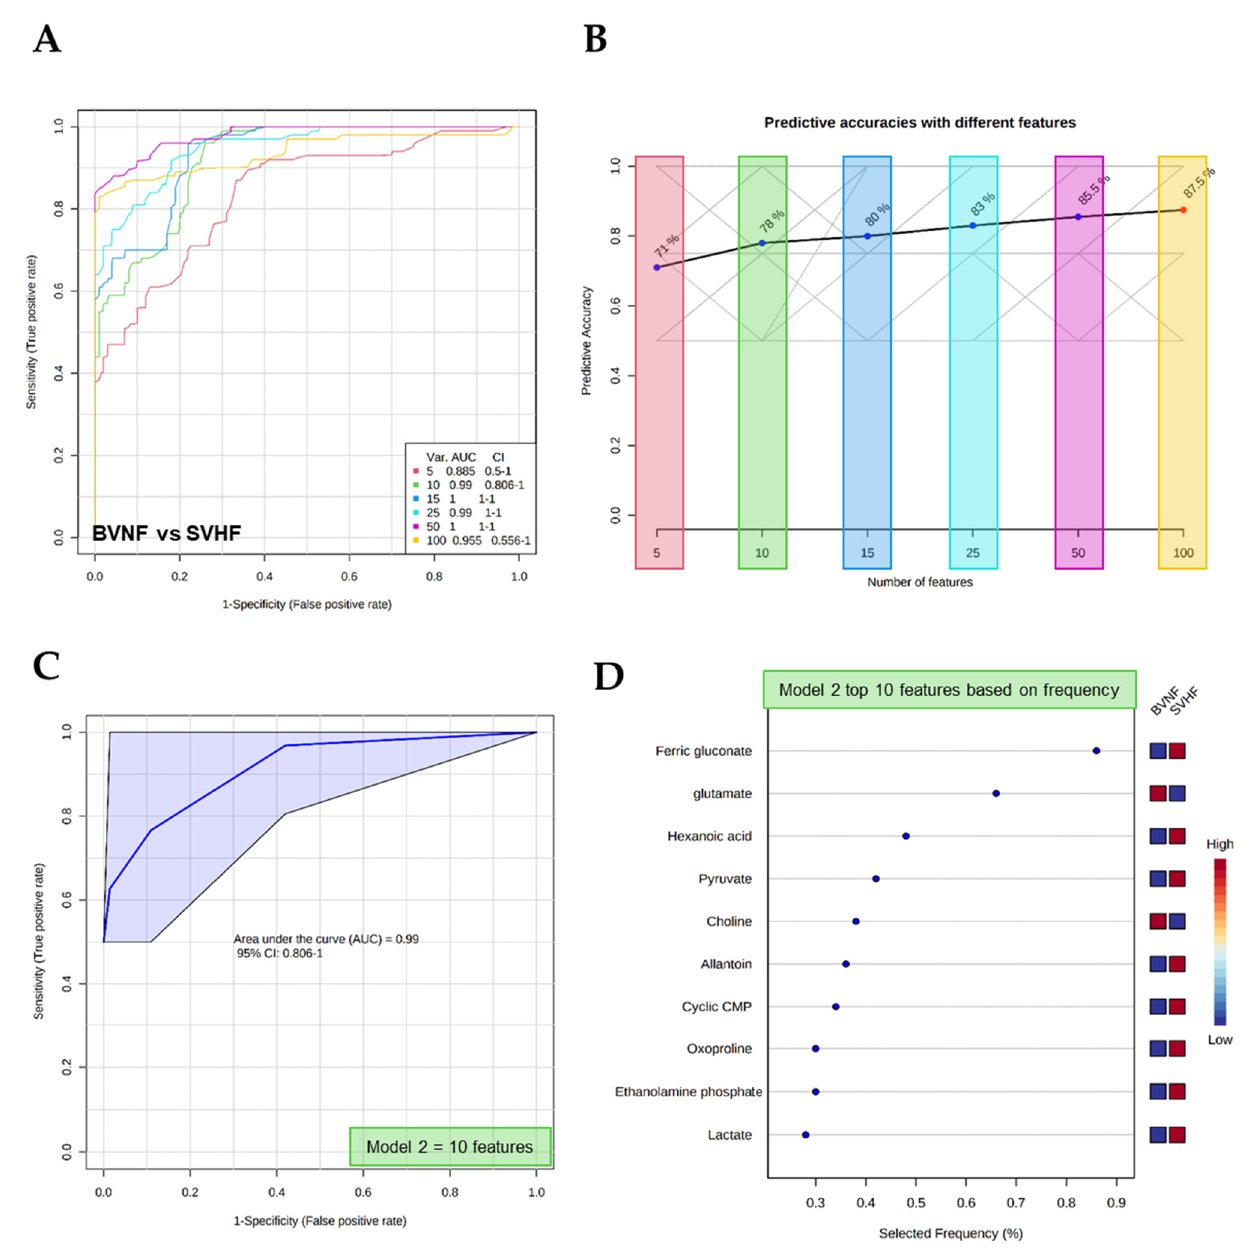
Figure 6. Multivariate analysis-based diagnostic potential of metabolomic profiles to distinguish BVNF from SVHF subjects. ( A ) ROC curves based on the cross-validation (CV) performance (curves are from all models averaged from all CV runs). ( B ) The predictive accuracy of each model based on the total number of metabolite features included in the model, from 5 to 100. ( C ) A specific ROC curve (Model 2) demonstrating the AUC and 95% confidence interval (CI). ( D ) The top 10 metabolite features, based on frequency, used for the predictive model (Model 2).